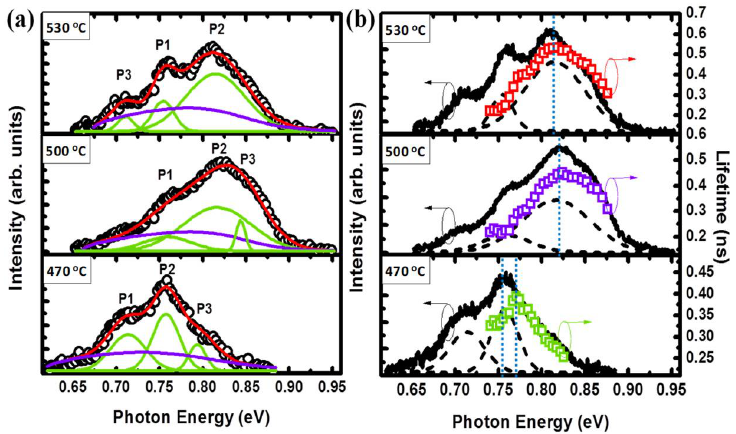
Figure 4. ( a ) Low-temperature photoluminescence spectra with fitting curve. ( b ) Energy-dependent TRPL and lifetime of the InN samples.